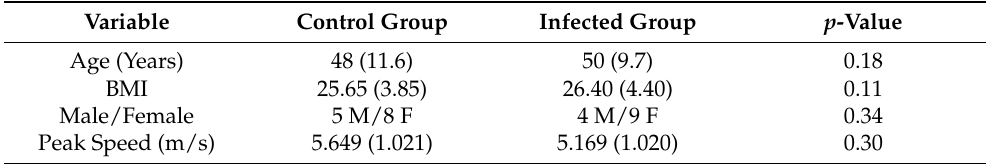
Table 2. Values, standard deviation and p-value of the variables: age, body mass index (BMI), sex, and peak velocity of the control and infected